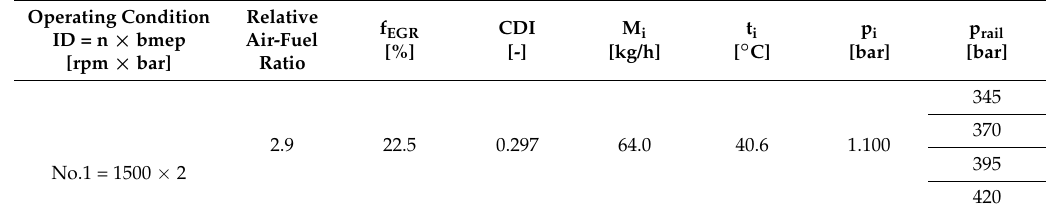
Table 7. Schedule of experimental activities for test Set 4 and average values of operating parameters (operating conditions No.1 and